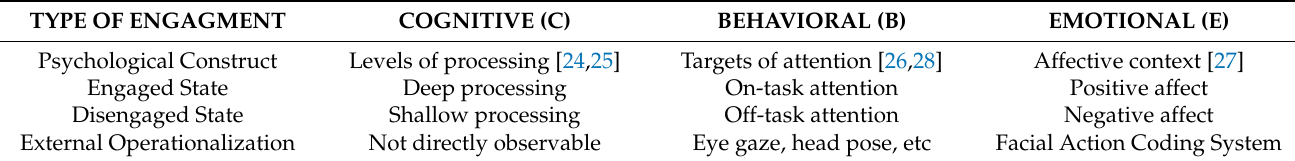
Table 1. Psychological Constructs for the Three Types of